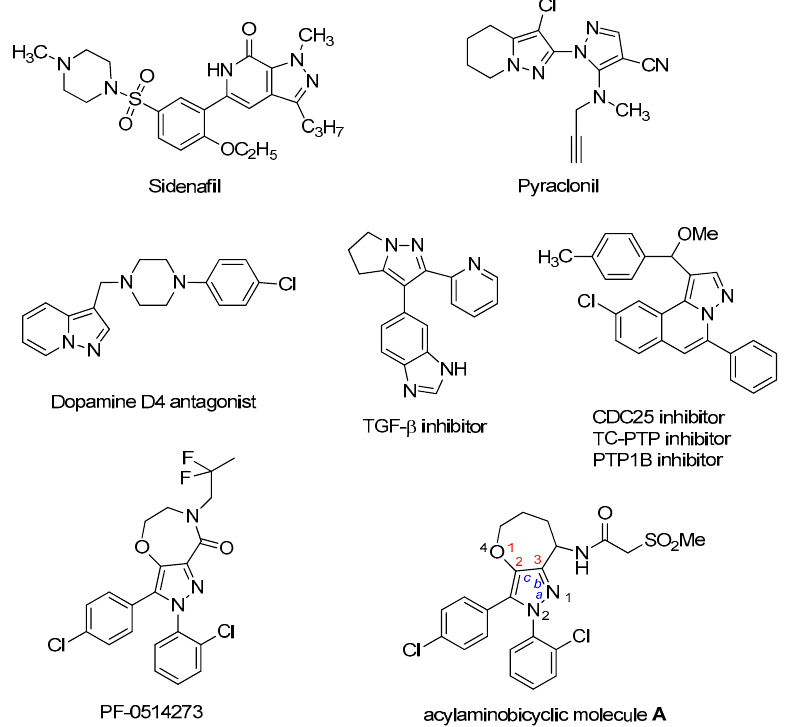
Figure 1. Examples of bioactive pyrazole-fused heterocyclic molecules. TGF- β : Transforming growth factor- β , CDC: Cell Division Cycle (Protein Phosphatase), TC-PTP: T-Cell Protein Tyrosine Phosphatase, PTP1B: Protein tyrosine phosphatase 1B.